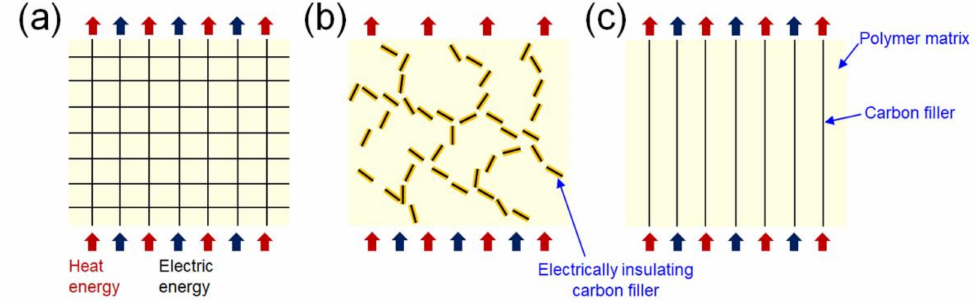
Figure 2. Schematics of thermal conductance in polymer composites with continuous 3D architectures of carbon fillers ( a ), electrically insulating carbon fillers ( b ), and vertically aligned carbon fillers ( c